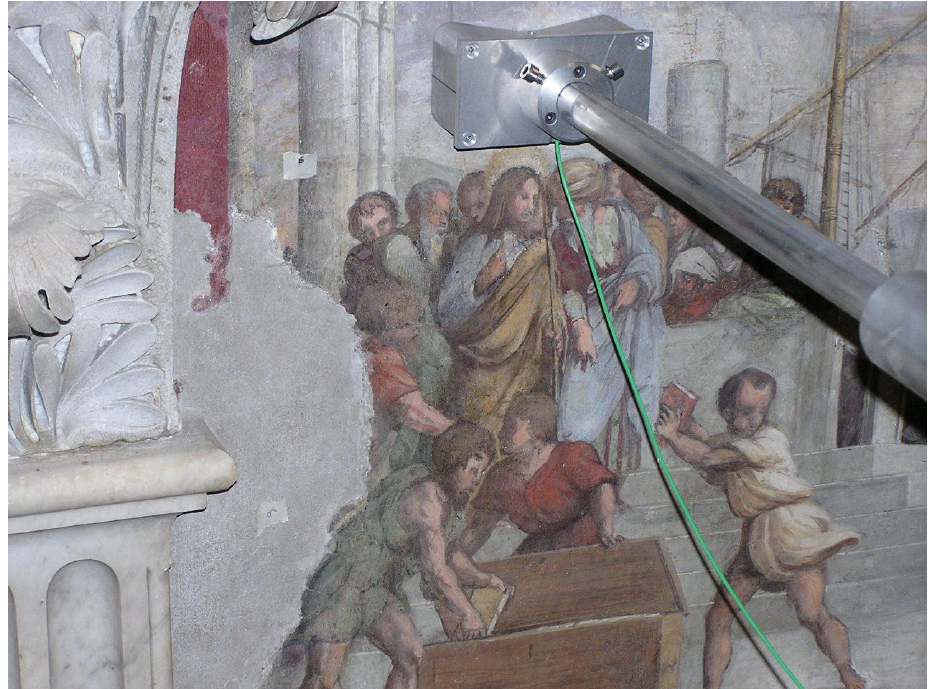
Figure 3. Single-sided NMR measuring moisture in a wall painting dating back to the XV century located in Nostra Signora del Sacro Cuore Church, Rome, Italy.